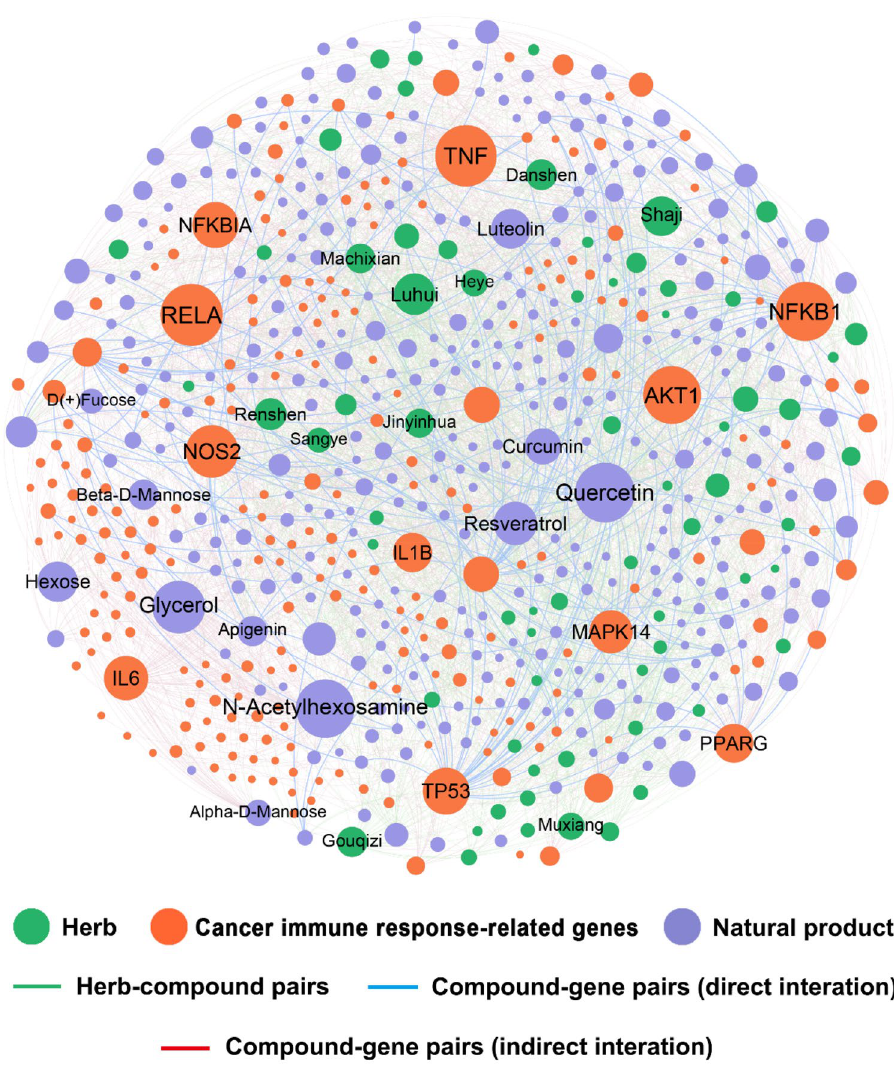
Figure 3. Herb-compound-target (H-C-T) network for natural products derived from 66 cancer-related herbs in cancer immunotherapy. The label font size and node size are proportional to degree (connectivity) of the item. Labels of the top 10 herbs, compounds, and targets with the highest degree are displayed. For the compound-target interactions that were labeled as direct and indirect interactions simultaneously, the direct ones were